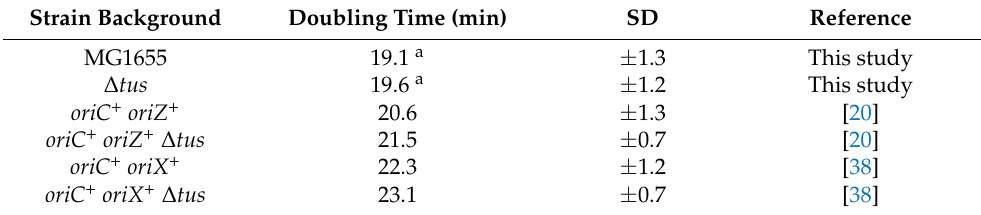
Table 1. Doubling times of various E. coli strains in the presence and absence of Tus. Strain